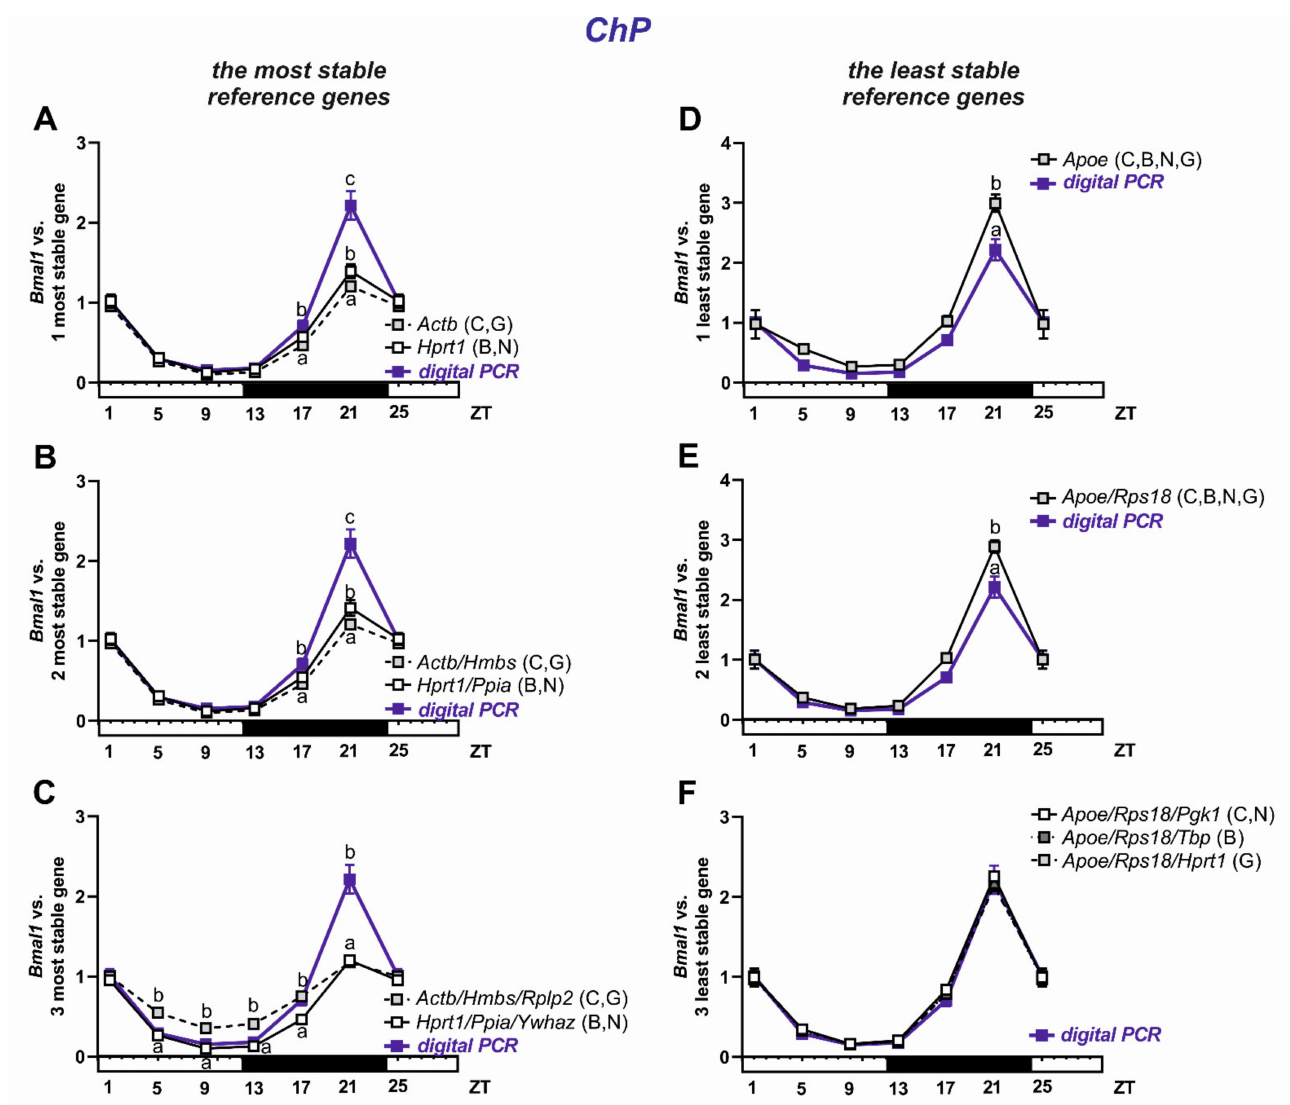
Figure 7. Relative expression of Bmal1 in isolated rat choroid plexus (ChP; n = 6, 6 females/3 samples and 6 males/3 samples for each time point). Data from ZT1 and ZT25 (ZT-Zeigeber Time) are double plotted in all panels. Data calculated vs. reference genes selected as the most stable, left panels ( A – C ), and the least stable, right panels ( D – F ). The additional blue plot refers to digital PCR results and different lower case letters indicate significant differences at p < 0.05 between qPCR and digital PCR results at a given time point. Abbreviations: C— ∆ Ct, B—BestKeeper, N—NormFinder,